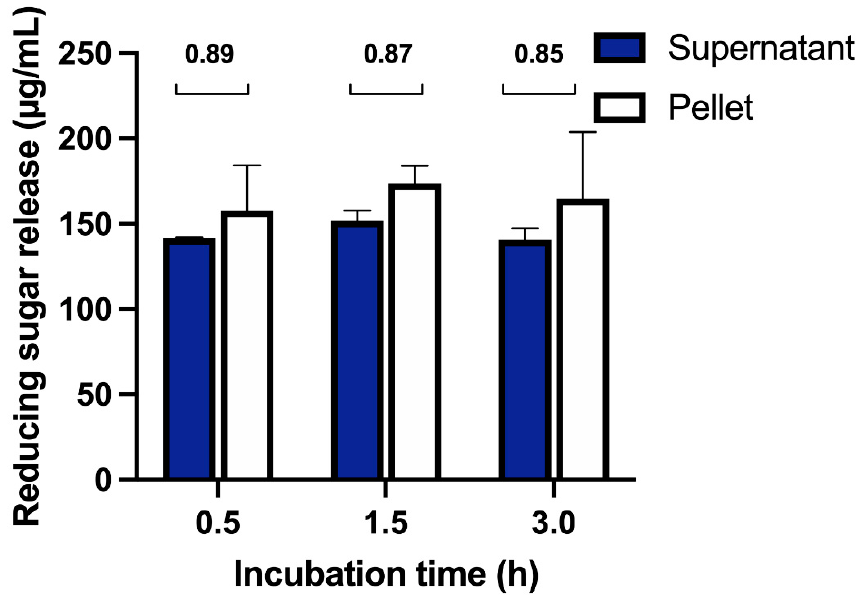
Figure 8. Processive activity test on RAC. Values are means and bars represent the standard deviations for three independent experiments.